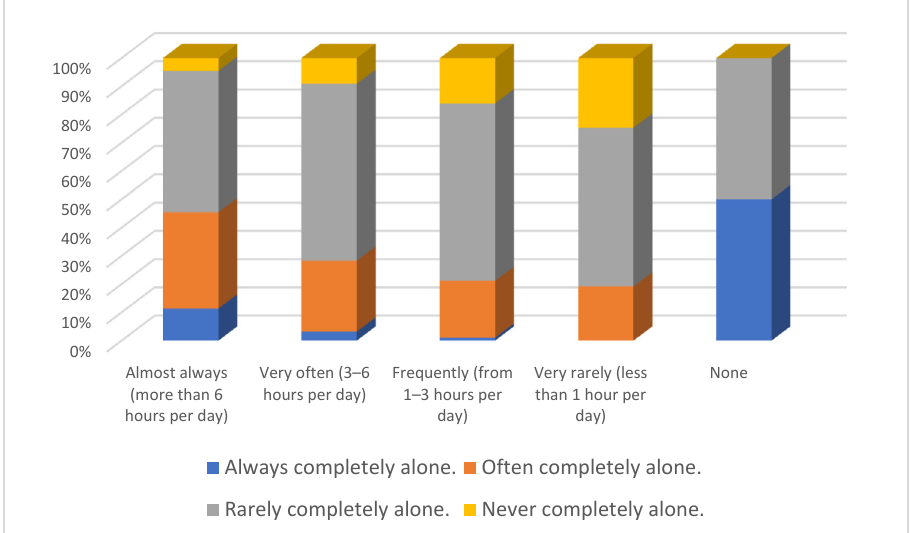
Figure 7. Proportion of lonely students by exposure to the internet on the phone.